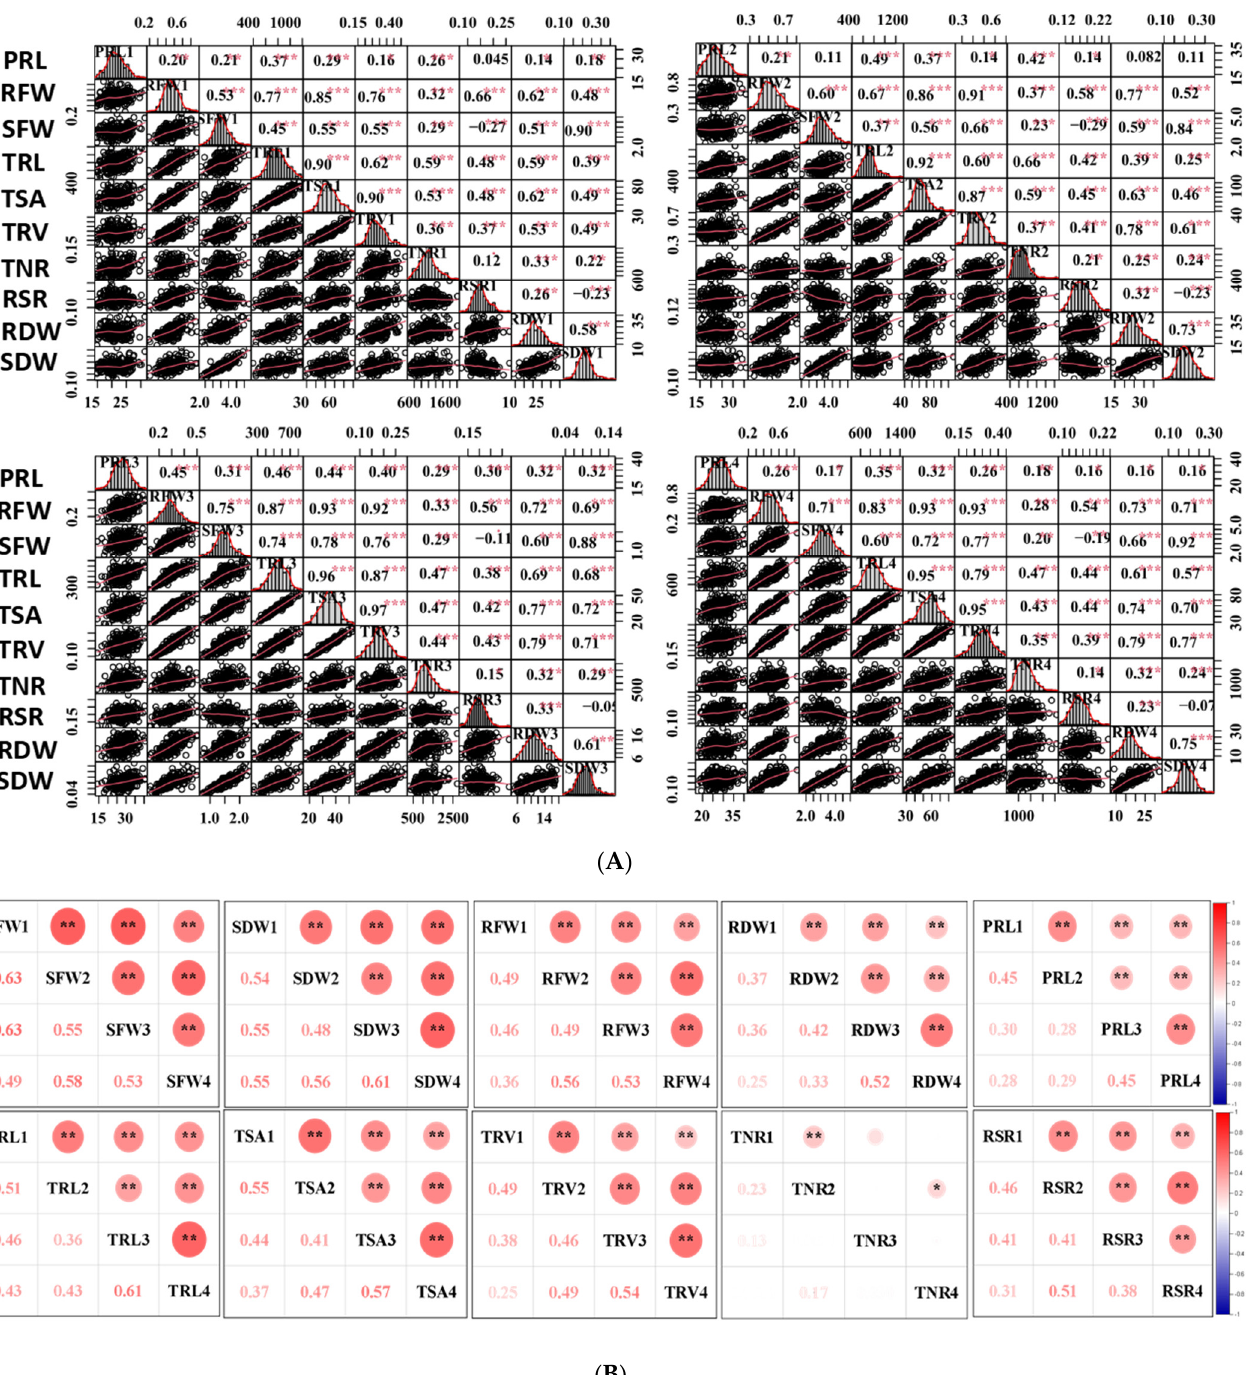
Figure 2. Correlation analysis of captured traits. ( A ) Correlations of captured traits in each experiment among RILs. For each trait, the frequency distributions of the adjusted means (diagonal), scatterplots (below diagonal), and values of the correlation coefficients (above diagonal) between pairs of traits are shown. ( B ) Correlations of each captured trait among the four experiments. Red and blue indicate positive and negative correlations, respectively. ***, ** and * denote significance at the 0.1%, 1% and 5% levels of probability among the RILs, respectively.